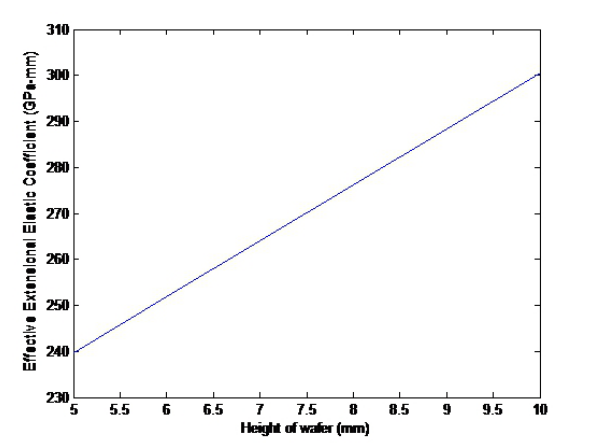
Figure 8: Plot of the effective ⟨︀ b 11 11 ⟩︀ extensional coeflcient vs. height of the piezoelectric